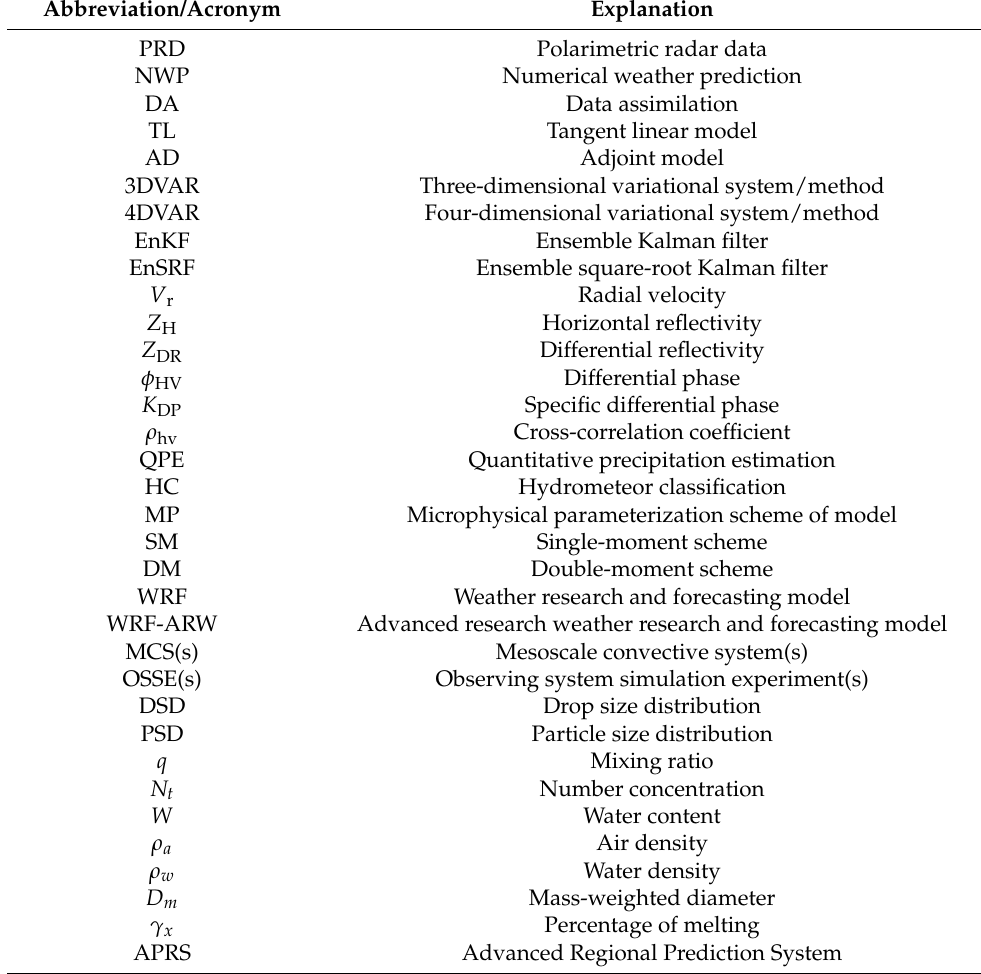
Table A1. Explanation of abbreviations and acronyms used in the